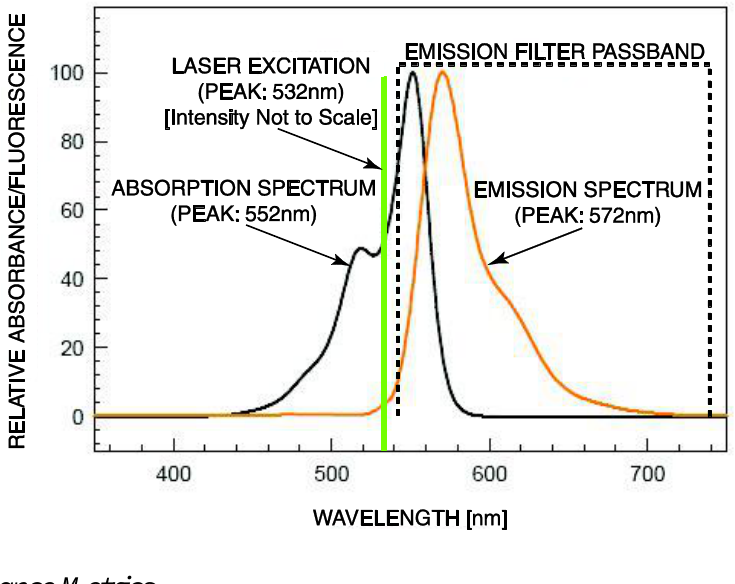
Figure 1. Key spectra of the commonly used Cyanine3 (Cy3) fluorescent